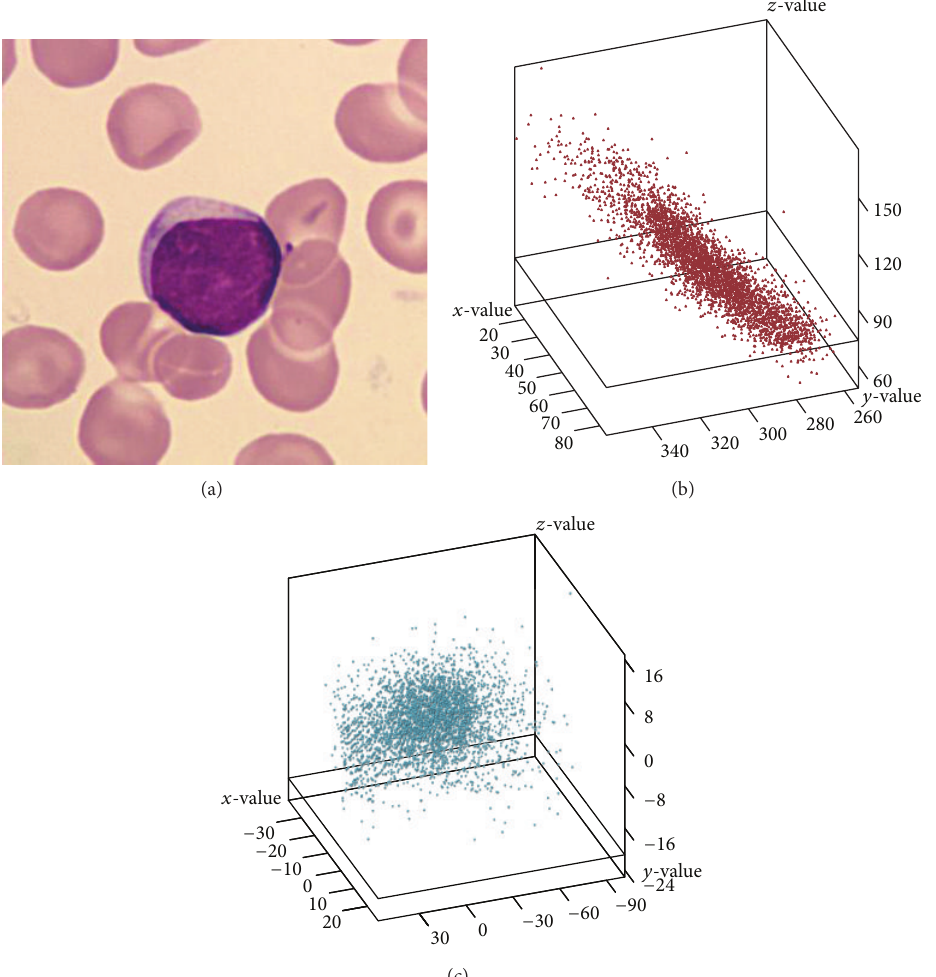
Figure 1: Blood cell images. (a) The original image. (b) The scatter plot of the collected pixels of the white blood cells in the 𝐻𝑆𝐼 color space. (c) The scatter plot rotated to a new coordinate